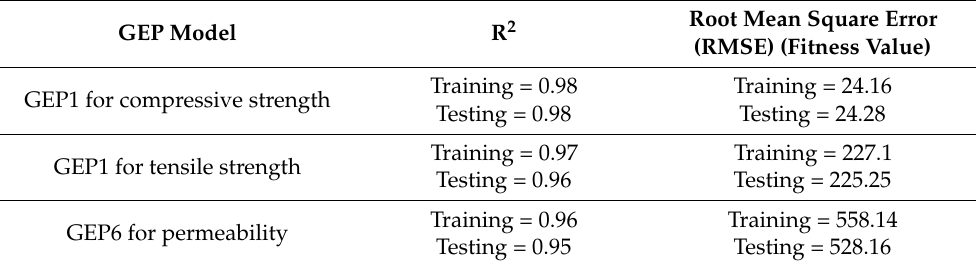
Table 11. Statistical errors for best models of